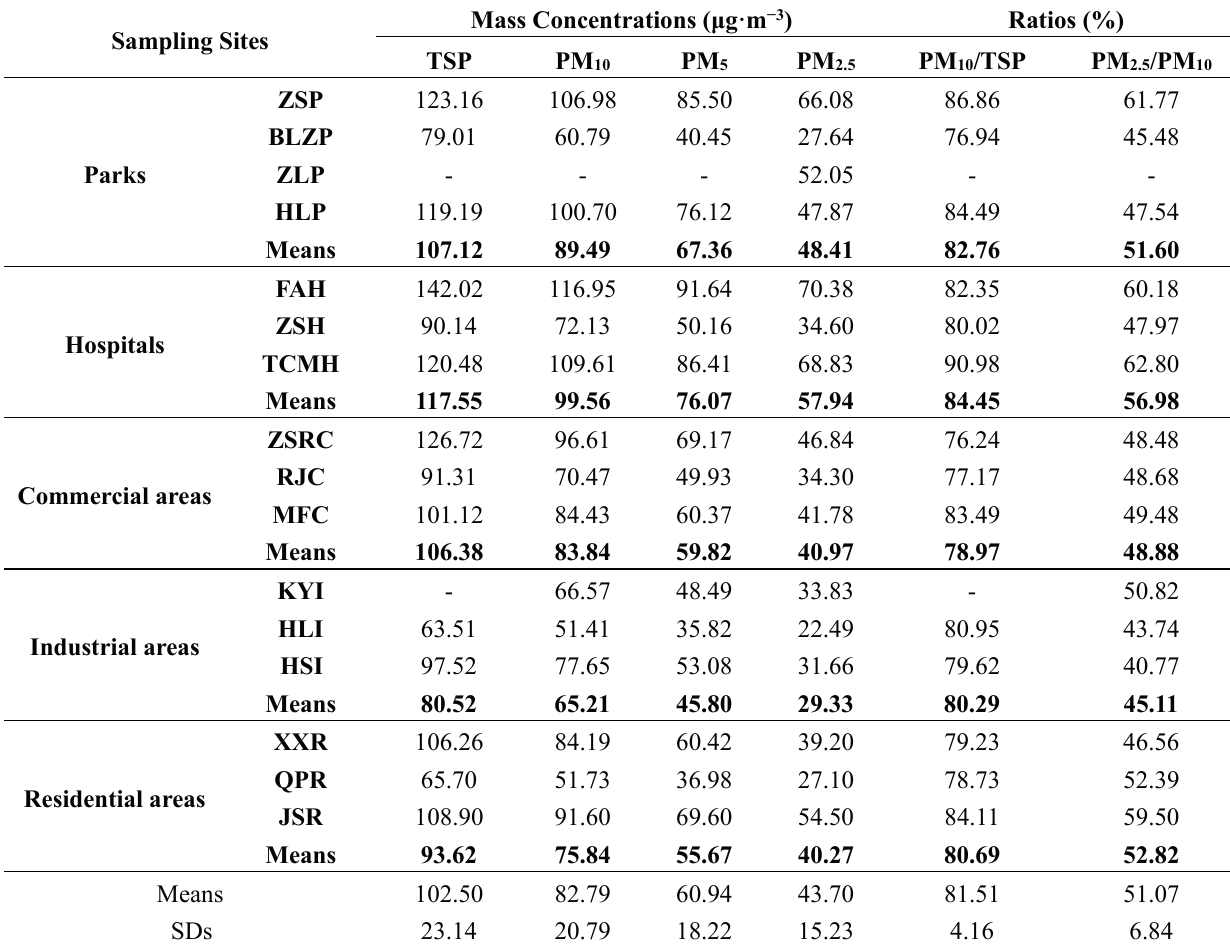
Table 2. Mass concentrations measured from the PM samples collected at different functional areas in